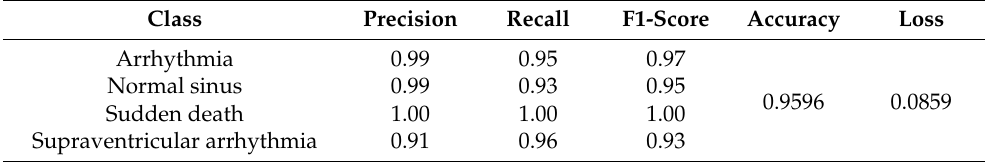
Table 3. Comparison of accuracy and loss with successive epochs.